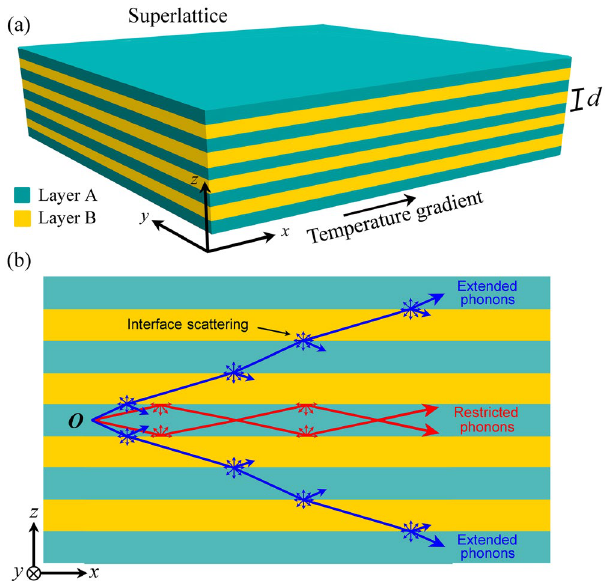
Figure 1. Schematic representation of phonon transport in superlattices. ( a ) A superlattice made of materials A and B in which a temperature gradient is applied along the x direction. ( b ) Phonons originating at point O within the superlattice can travel within a single layered, i.e. layer-restricted (red) or they can cross multiple interfaces and propagate in different layers, i.e. extended